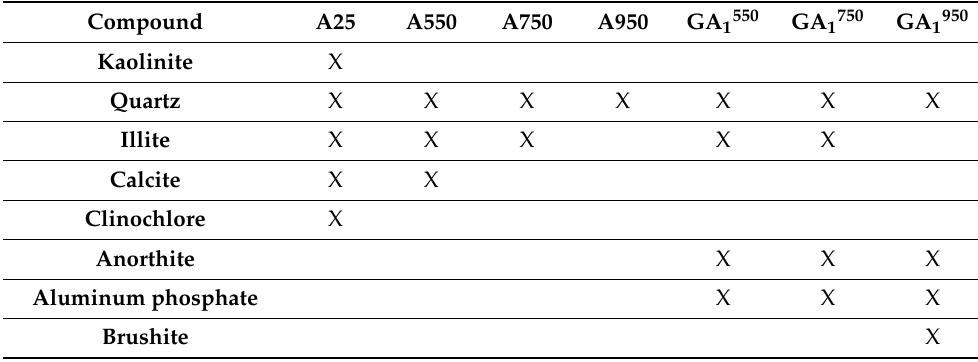
Table 2. A summary of the crystalline phases present in the different